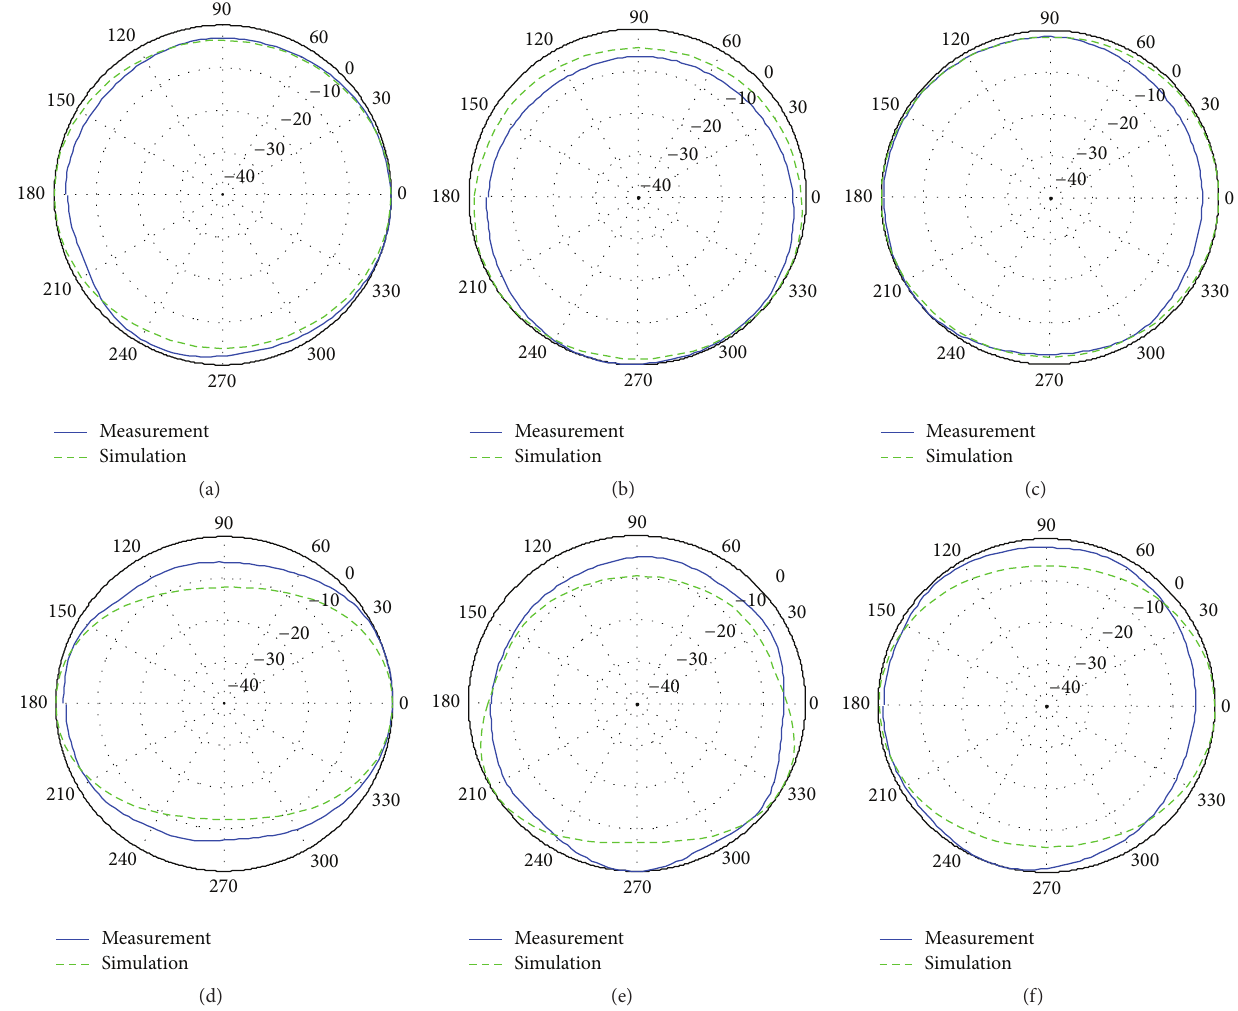
Figure 10: Simulated and measured 𝐻 -plane radiation patterns of (a) CPW-fed slot antenna, (b) cactus antenna, and (c) miniaturized cactus antenna at 5GHz and (d) CPW-fed slot antenna, (e) cactus antenna, and (f) miniaturized cactus antenna at